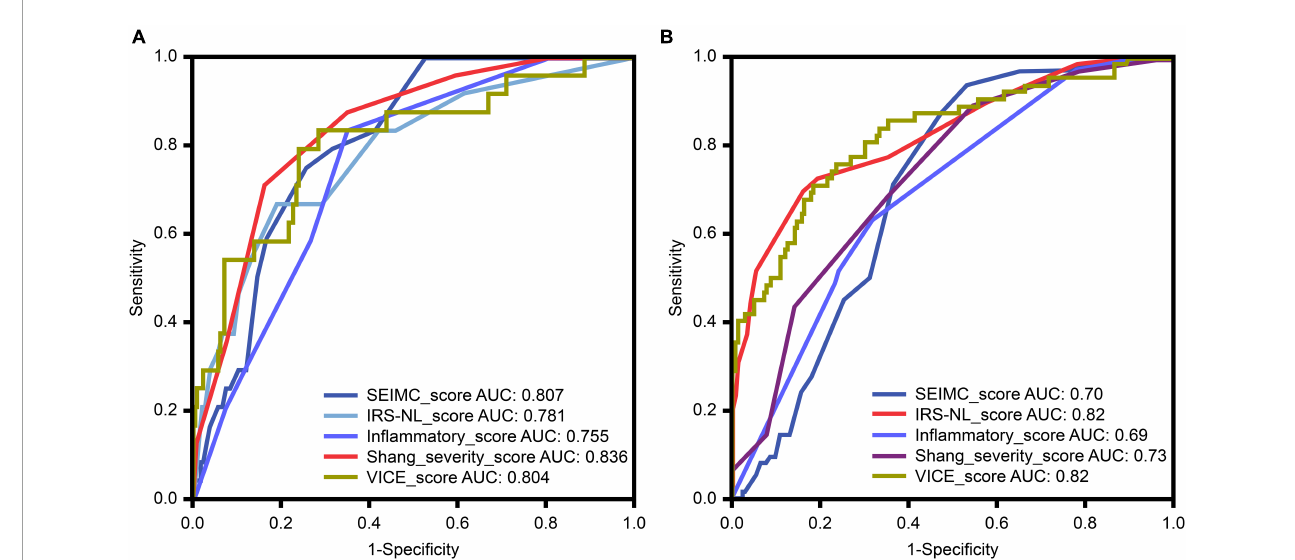
FIGURE2 (A) The receiver-operator characteristic (ROC) curve (with AUC) for predicting mortality among patients with coronavirus disease 2019 (COVID-19) in our cohort. (B) The ROC curve for predicting mechanical ventilation requirements among patients with COVID-19 in our cohort. HR, hazard ratio; AUC, area under the curve; SEIMC, Spanish Society of Infectious Diseases and Clinical Microbiology; IRS-NLR, intubation risk score-neutrophil/lymphocyte ratio; VICE, ventilation in COVID estimator.